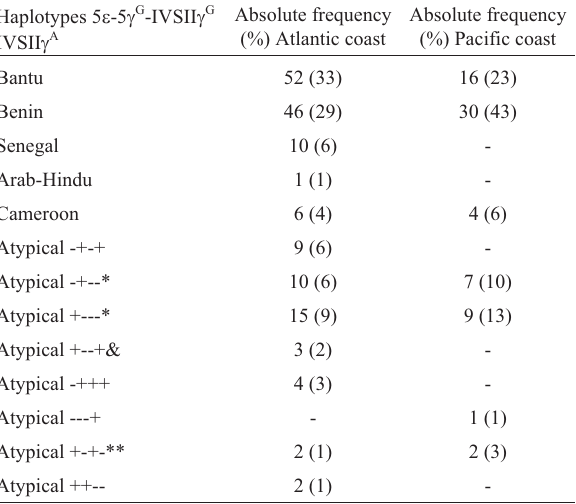
Table 1 - Distribution of haplotypes associated with hemoglobin S in Buenaventura, Cali, Montería and Cartagena, Colombia. Frequencies were determined for the number of haplotypes associated with the beta- globin